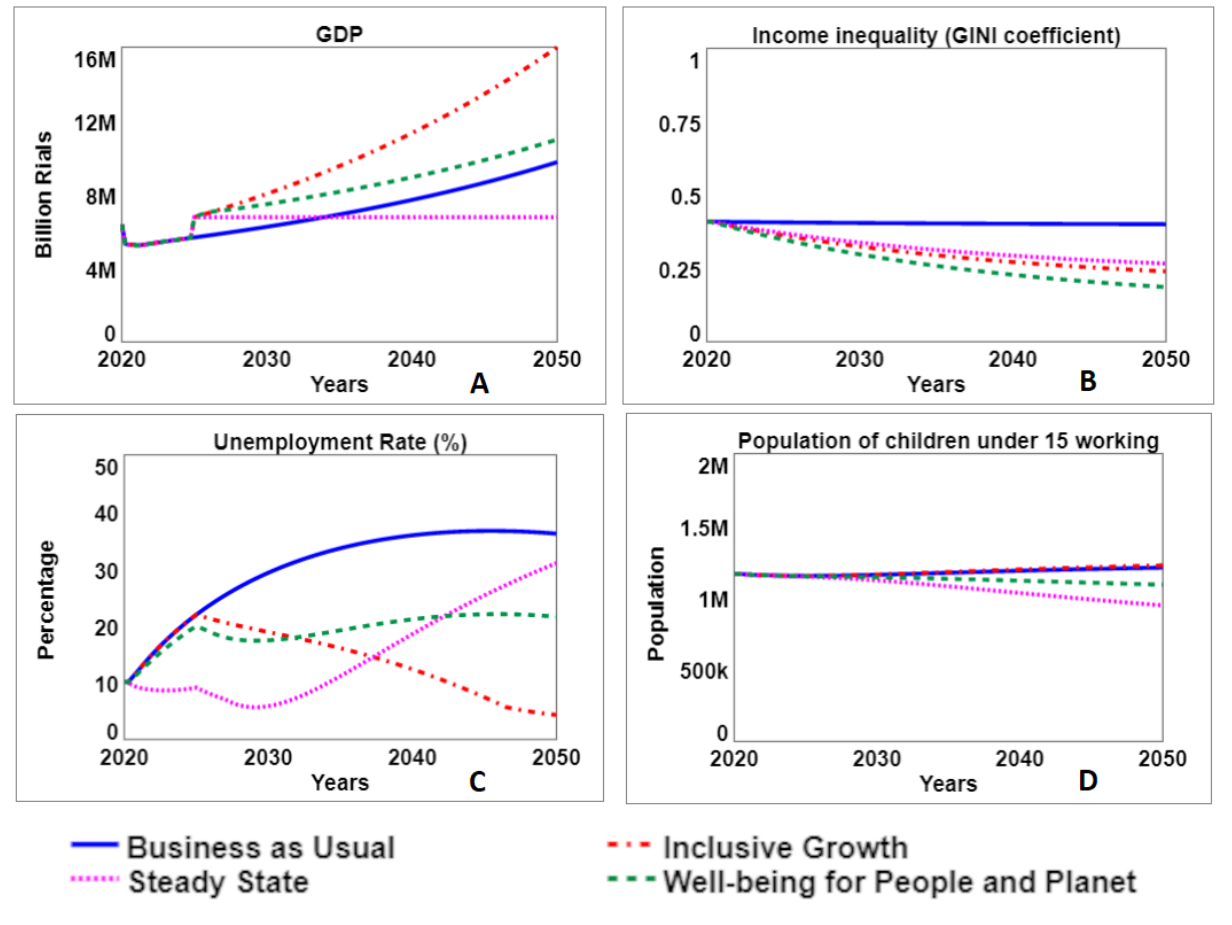
Figure 8. Indicators of SDG-8 in the